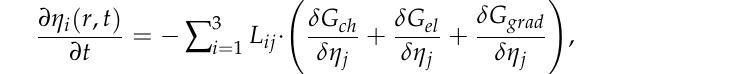
research is shown in Figure 1. The evolution equation for the martensitic transformation based on the three Bain strain groups in this study is expressed as Equation (1).